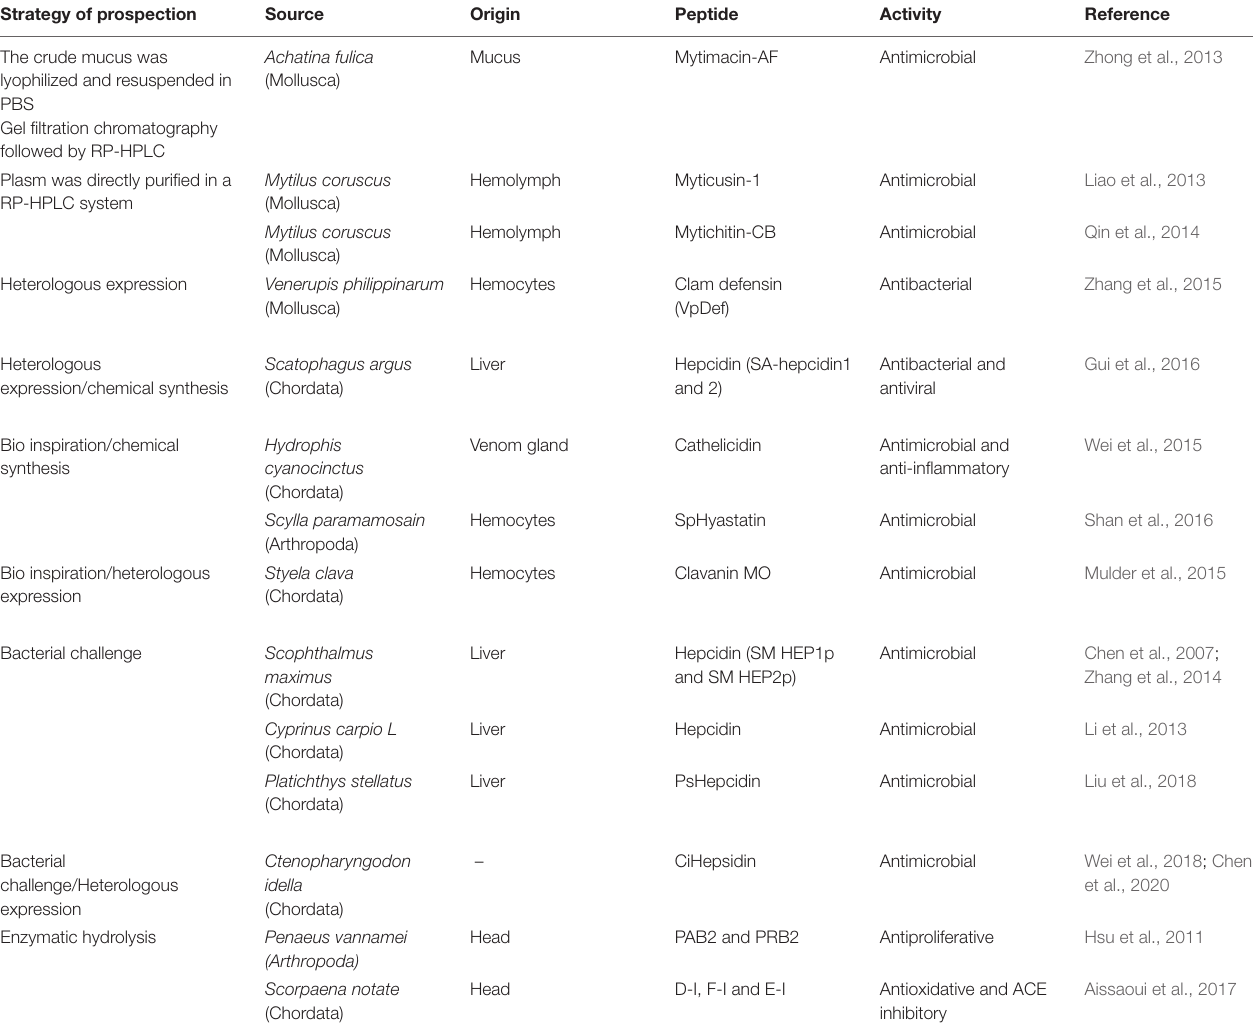
TABLE 1 | Strategies to obtain bioactive peptides from marine